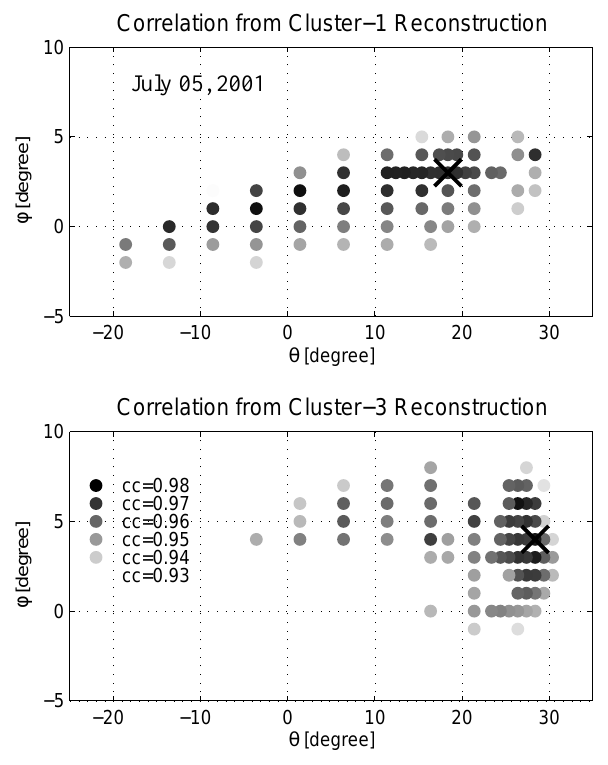
Fig. 15. Dependence of the correlation coefficient on the choice of the invariant axis for the reconstructions from the C1 (upper panel) and C3 (lower) traversals on 5 July 2001. The format is the same as in Fig.